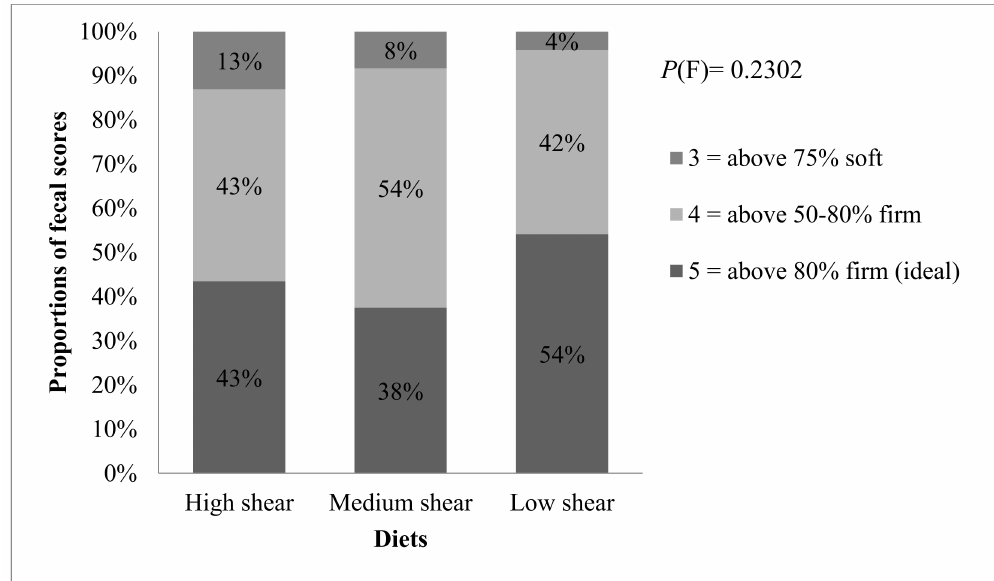
Figure 1. Relative proportions of stool scores for dogs fed dietary treatments produced at high, medium and low shear diets ( n = 23, 24 and 24, respectively).